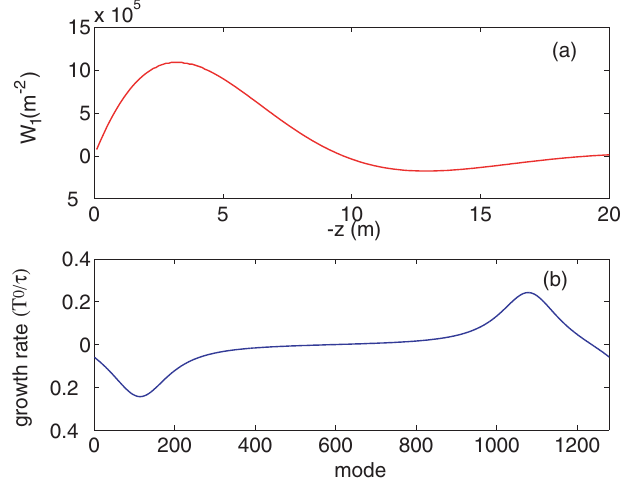
(cid:3) ] of =(cid:6) (cid:2) ! m 0